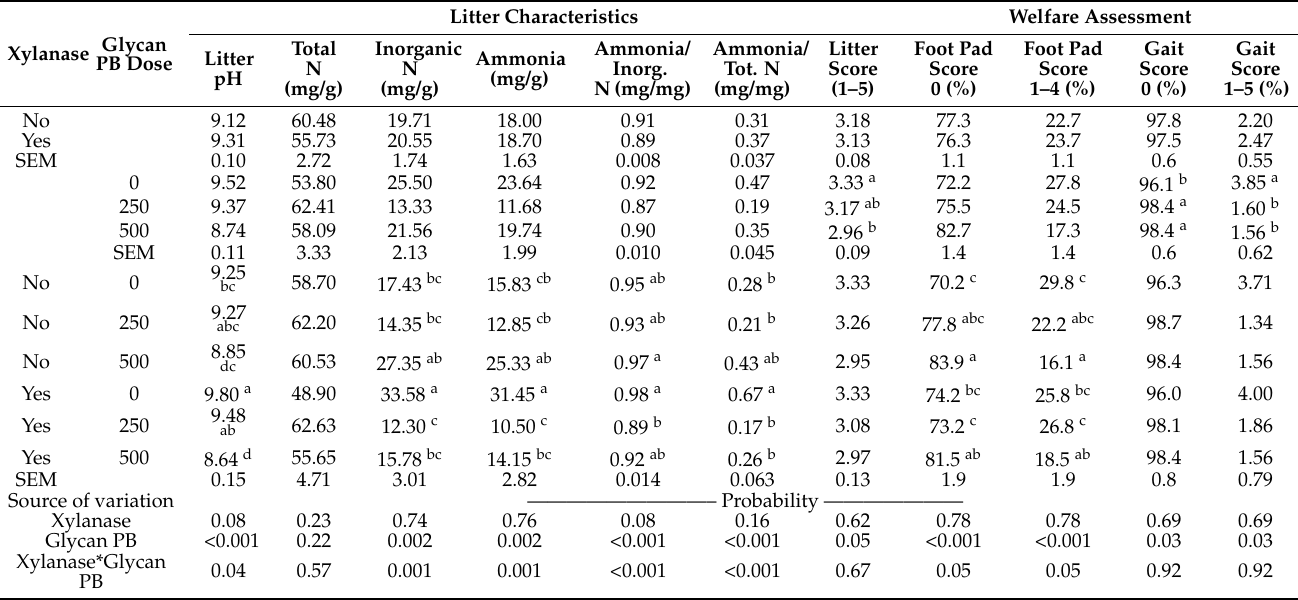
Table 4. Effects of a precision biotic (Glycan PB) ingredient 1 supplemented at different doses in feed without or with the inclusion of a xylanase enzyme on the litter characteristics, foot pad lesions, and gait scores of broiler chickens raised in floor pens, evaluated at 35 d of age (Trial